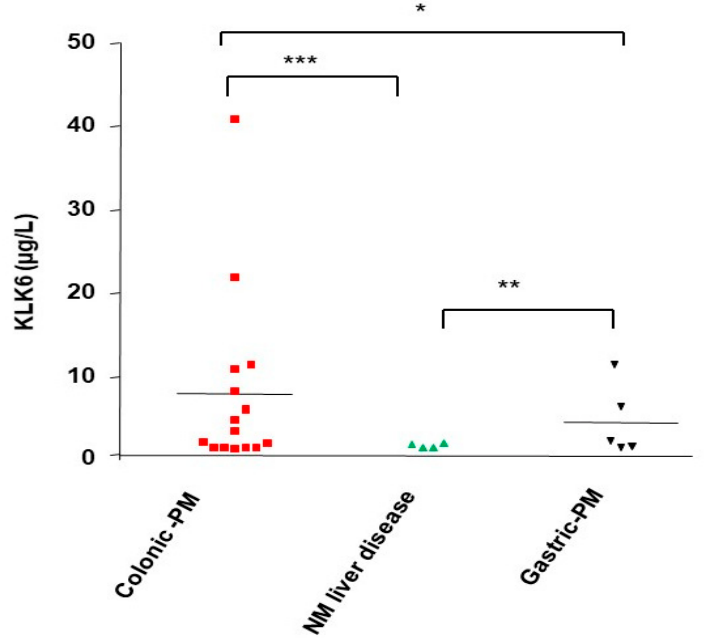
Figure 9. Immunodetection of KLK 6 in ascitic peritoneal metastasis from human colorectal cancer. Ascitic fluids were collected from peritoneal metastasis from human colorectal cancer (Colon-PM), (Gastric-PM) or from non-malignant liver diseases (NM Liver disease) and KLK6 expression was estimated by a sandwich-type ELISA (see Material and Methods). Protein values represent the mean concentration of KLK6 ( µ g/L). Data are shown as mean ± SEM. * p < 0.05; ** p < 0.01; *** p < 0.001.